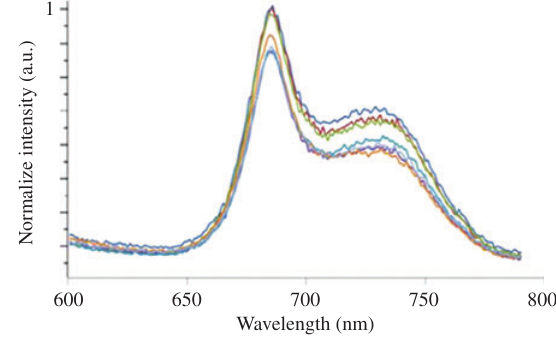
Fluorescence spectra of an untreated leaf measured at different spots (excitation wavelength: 430